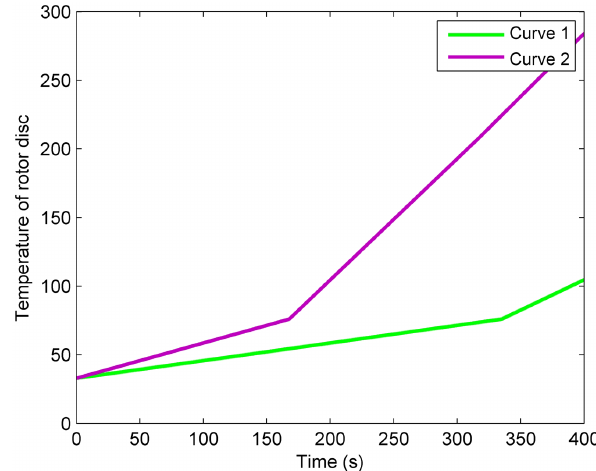
Figure 14. Energy consumption characteristic curves of the elec- tromagnetic brake under different braking situations.